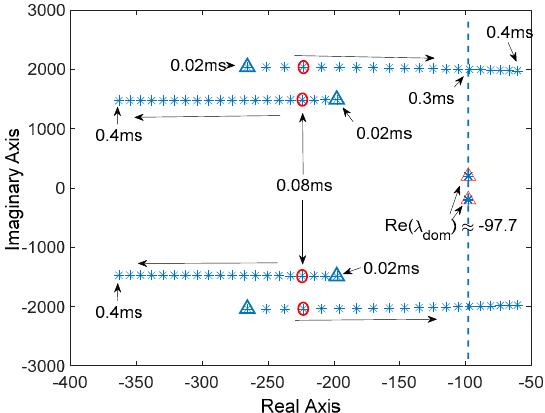
varying from 0.02 mH to 0.4 mH; ( b ) Zoom.